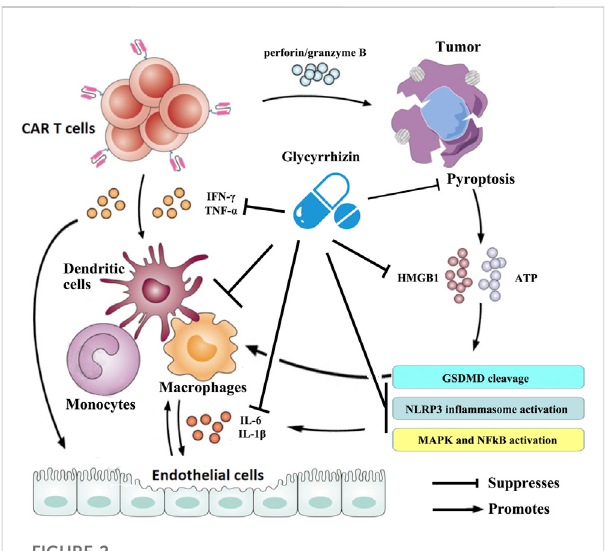
FIGURE 2 Schematic illustration of the therapeutic bene fi ts of glycyrrhizin for CRS triggered by CAR T-cell therapy. The fi gure is drawn based on Figure 1 of Schubert et al. (2021) and Xiao et al.